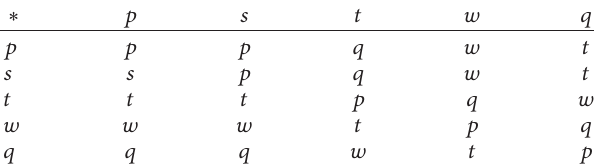
Table 7: Cayley table of the binary operation ∗ .